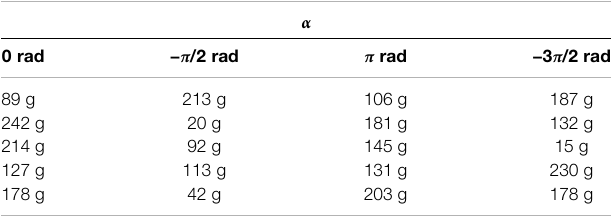
TABLE 1 | Con fi gurations for model veri fi cation assessment. The tendon tensions of τ 1 are indicated by the mass of the precision weights. The weights are sampled from an uniform random between 0 and 250 g. Adapted from the machine learning literature (Bergstra and Bengio (2012)), we prefer sampling from a random distribution over a grid search